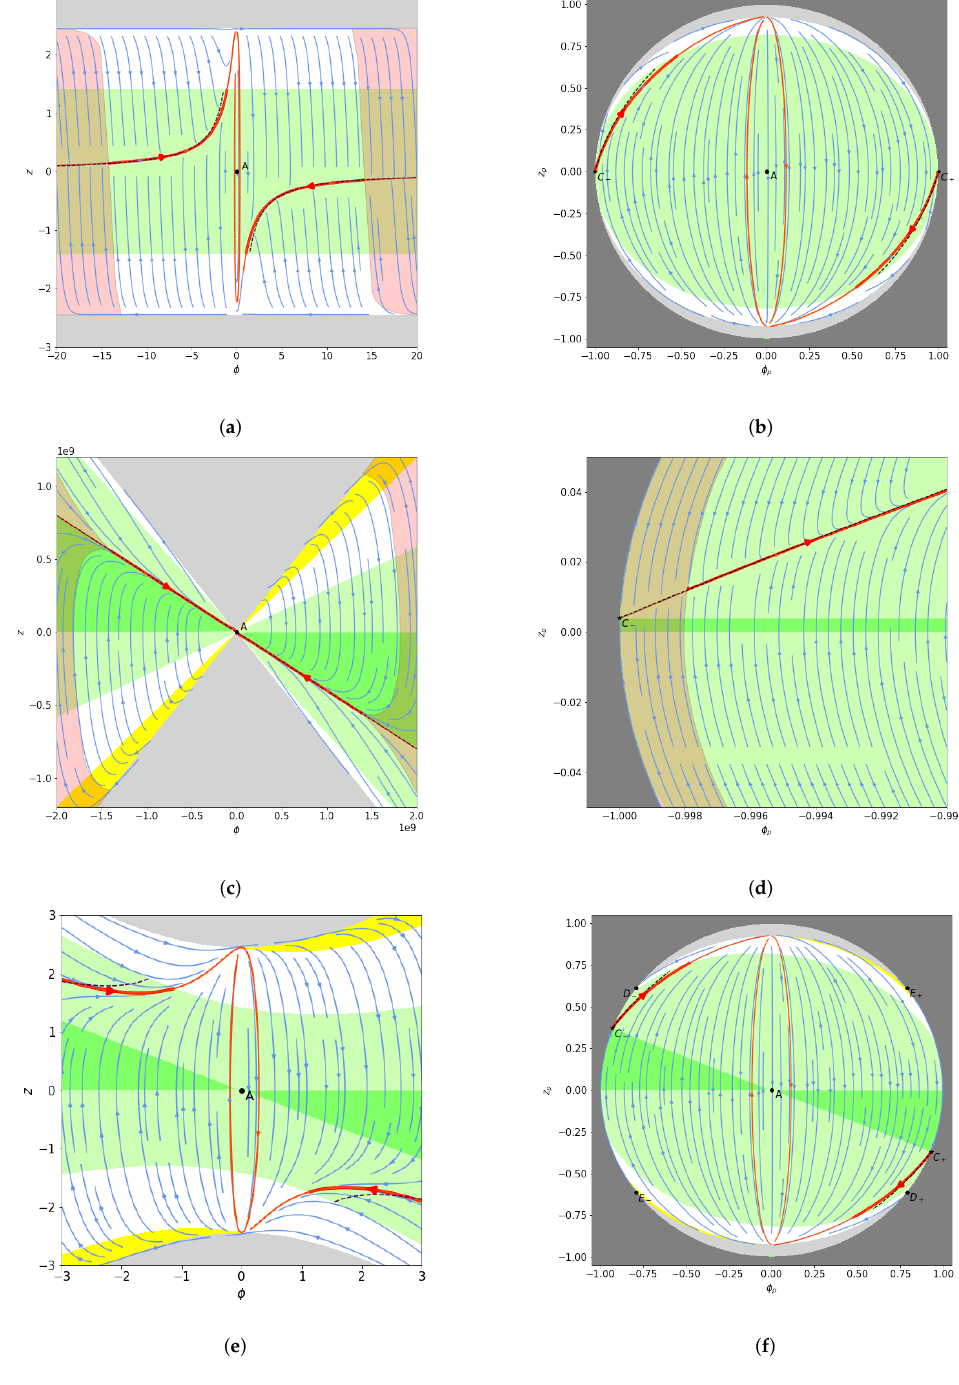
Figure 1. Cosmological dynamics of the quadratic model (31) with Λ = 0, and ξ = 0 ( a , b ), ξ = 0.001 ( d ), ξ = 0.1 ( c , e , f ). Green background stands for superaccelerated, light green accelerated, white decelerated, and yellow superstiff expansion, while grey covers the unphysical region. Orange trajectories are heteroclinic orbits between the fixed points, the wider red part of the master trajectory highlights the 50 last e-folds of inflation, while red semi-transparent cover shows the basin of initial conditions leading to 50 e-folds. The dashed curve marks the path of slow roll approximation.